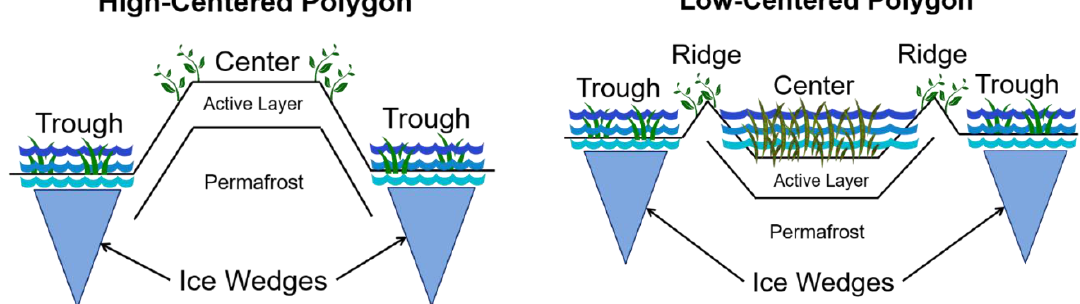
Figure 1. Cross-sectional illustrations of a high- ( left ) and low-centered ( right ) ice wedge polygon, showing their different microtopographies (e.g., trough, ridge, center) and representations of possible variations in hydrology, vegetation, and thaw depth.